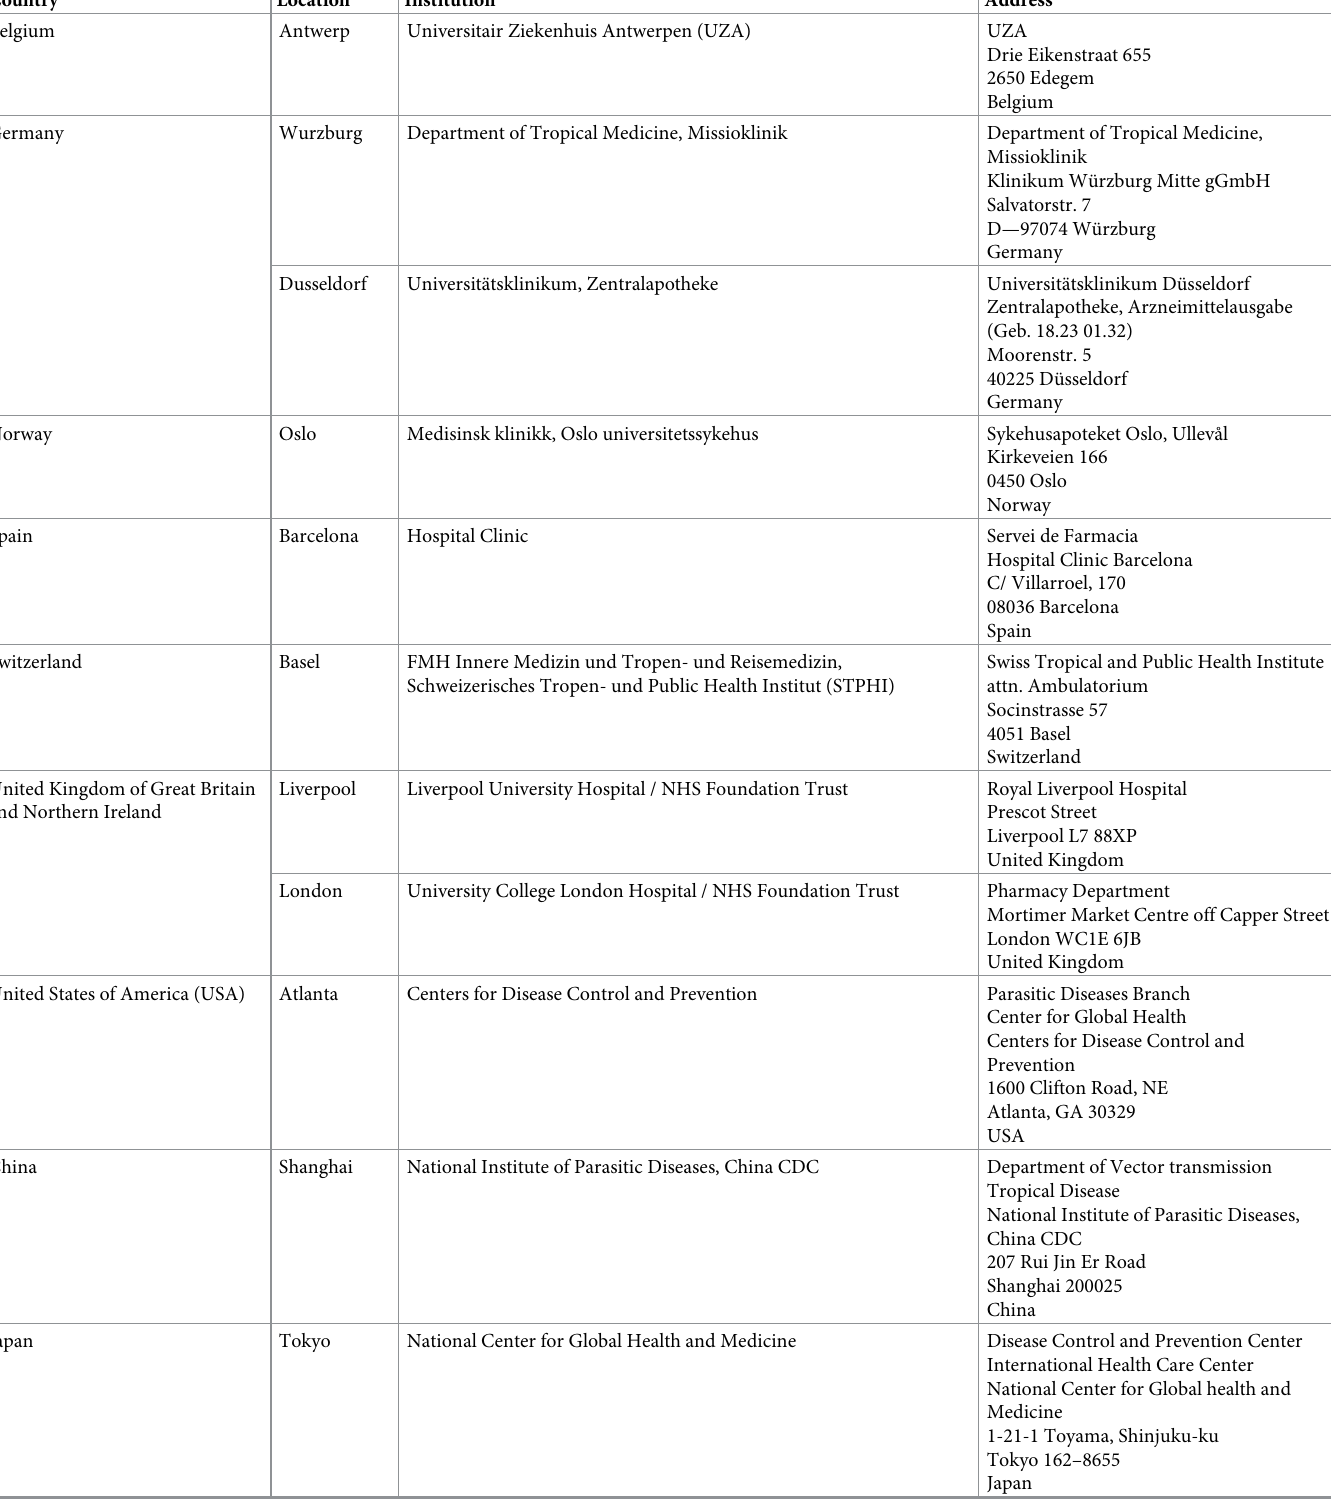
Table 1. Institutions keeping prepositioned stocks of antitrypanosomal medicines for the treatment of HAT cases detected in non-DEC.